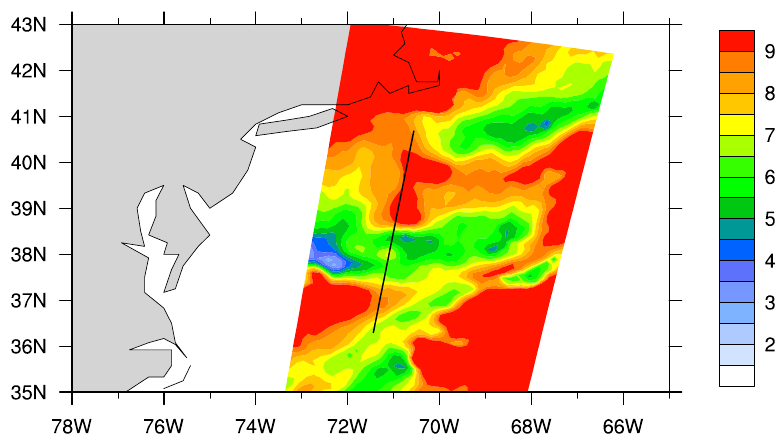
Figure 17. The Advanced Scatterometer (ASCAT) observed wind speed (color shaded) near the Gulf Stream region on 15 October 2012. The wind speed along the backline is selected for comparison with the modeled surface wind.